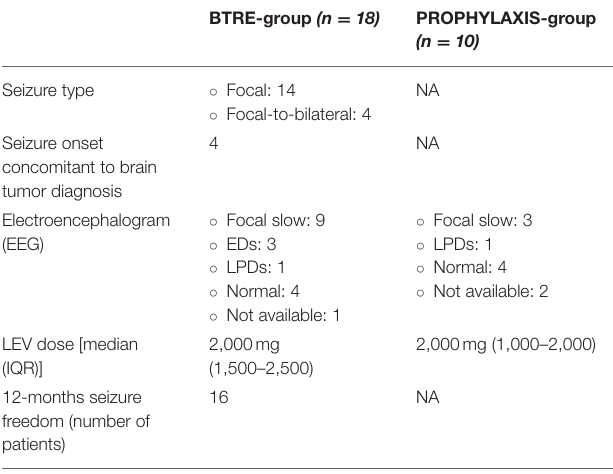
TABLE 2 | Seizure prevalence and electrophysiological assessment